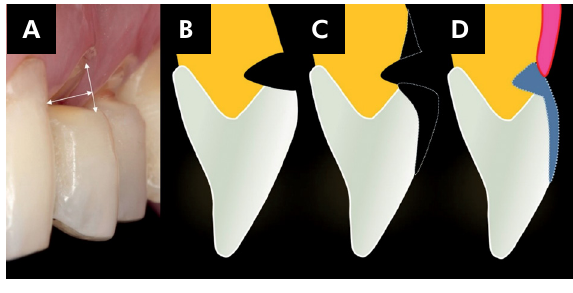
Figure 9. Clinical and schematic view of the B+V tooth surface (a, b; respectively). Because V-shaped non-carious cervical lesions (NCCLs) can be extremely deep with a depth/height ratio close to 1 (a), a partial restoration performed to treat this defect may be challenging due to excessive removal of sound structure for re-establishing an adequate emergence profile. The two black zones delimited by white dotted lines represent the extent of the structure that should be removed to provide a proper and harmonious emergence profile (coronal zone) and to smooth the root surface to receive the graft/flap (apical zone) (c). The blue area represents the partial NCCL restoration performed for treating extremely deep V-shaped defects